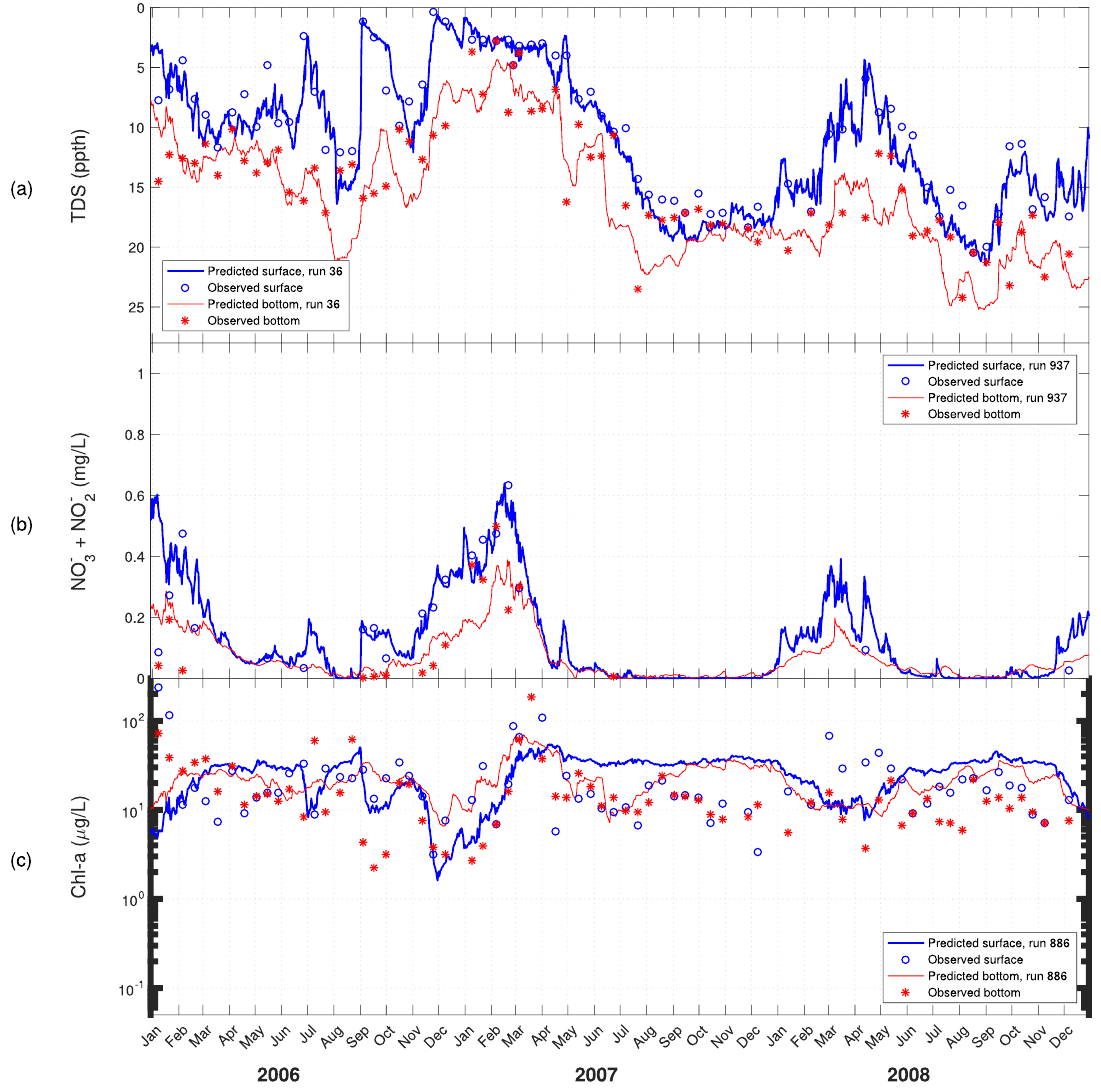
Figure 11. Time series for predicted versus observed values of: ( a ) salinity; ( b ) nitrate + nitrite; and ( c ) chlorophyll-a at ModMon 100 for 2006–2008.